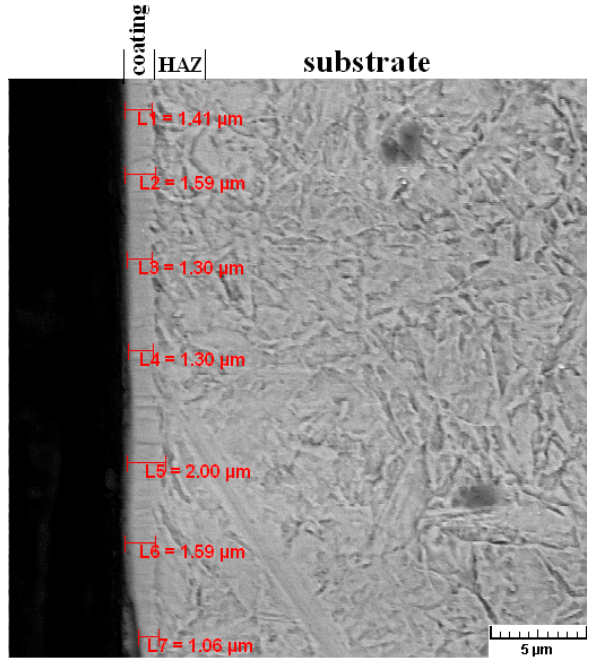
Figure 7. SEM graph from cross section of specimen AFD250510.